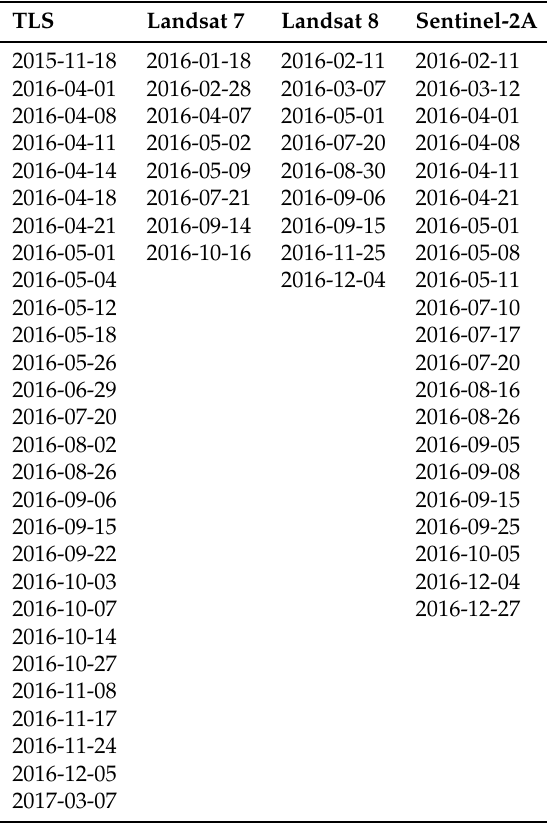
Table A1. List of TLS and satellite sampling dates. TLS Landsat